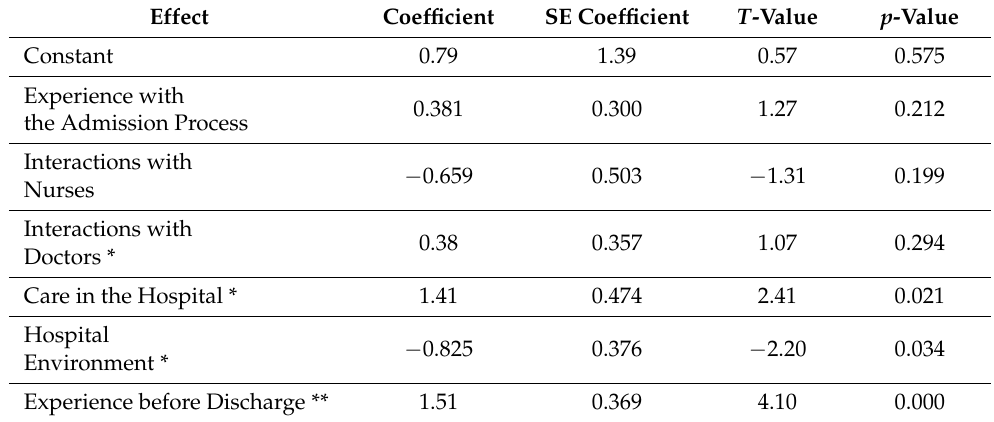
Table 5. Multiple linear regression analysis between the parent respondents and their overall